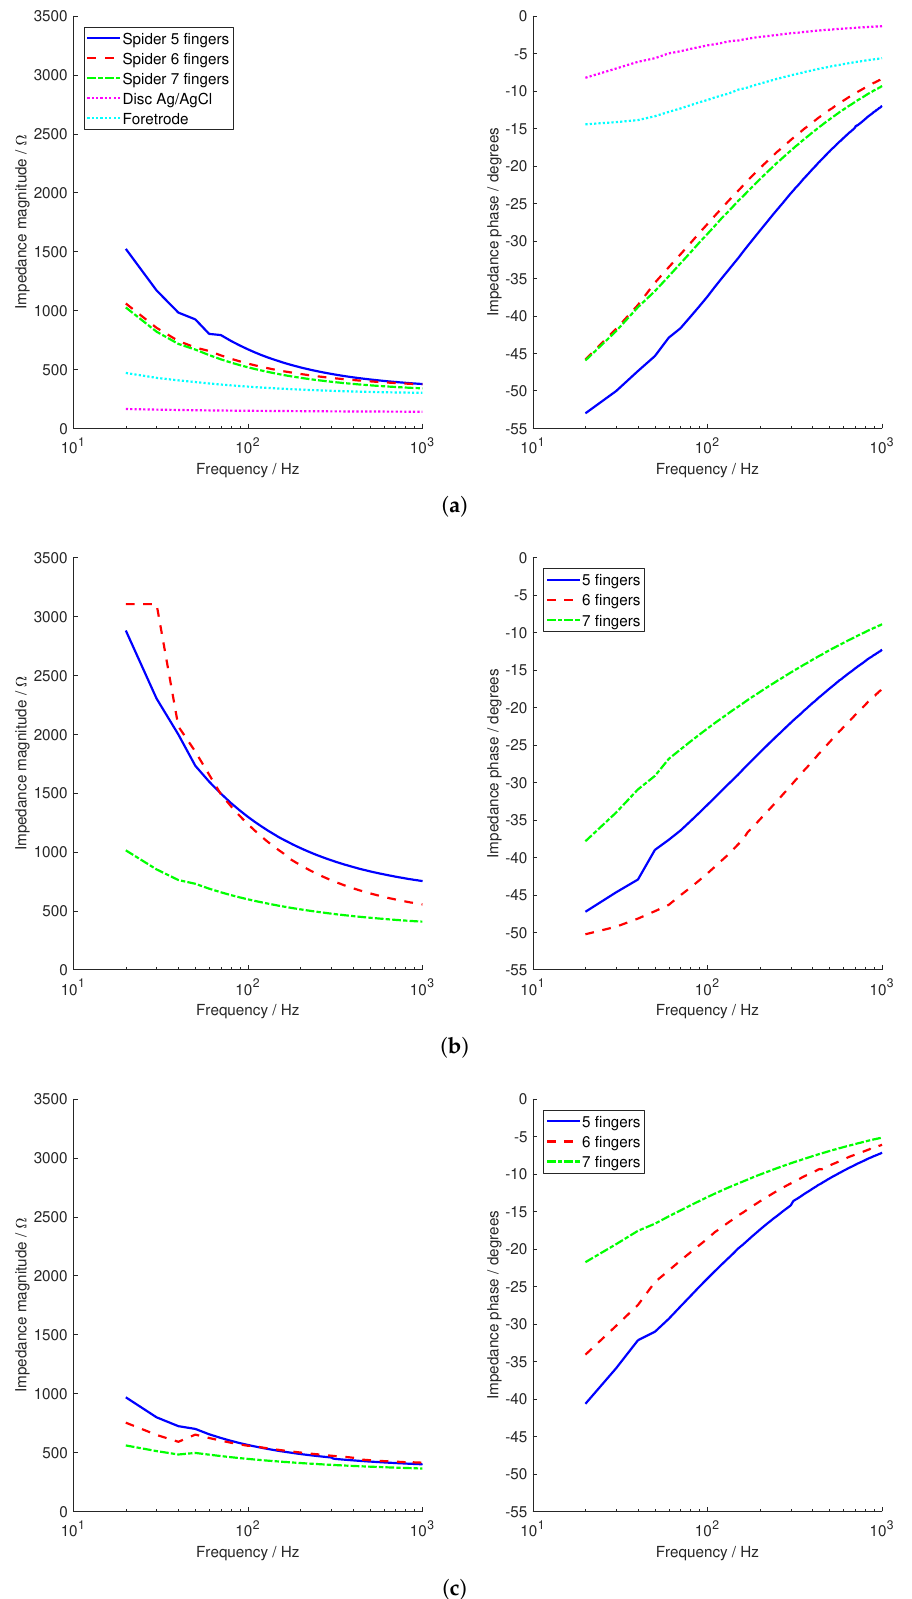
Figure 8. Contact impedance (magnitude and phase) for the different electrode configurations. ( a ) Spider electrode and the Ag/AgCl disc and Foretrode comparison electrodes. ( b ) Anti-spider electrode. ( c ) Spiny